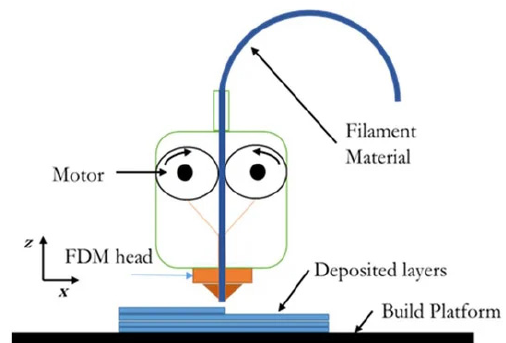
Figure 16. Scheme of SLA equipment. Adapted from [64]. Open access, Copyright MDPI.